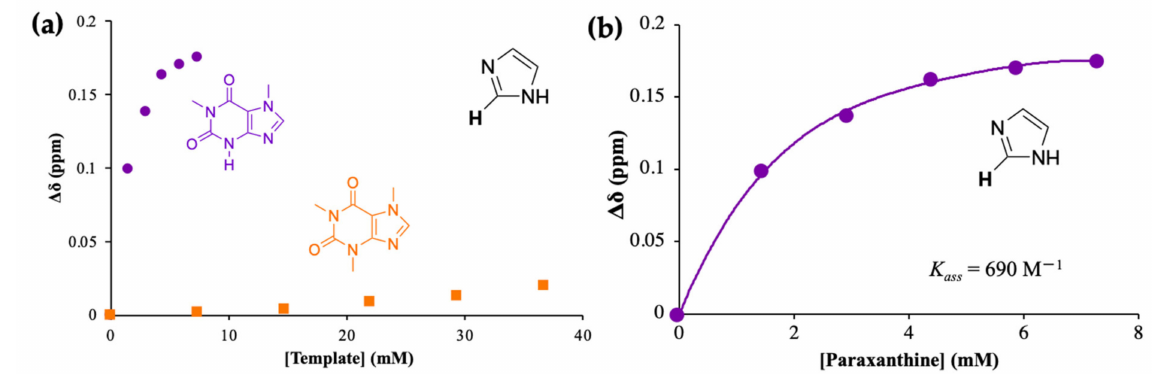
Figure 3. ( a ) 1 H NMR titrations of imidazole (IM) with paraxanthine (PX, purple) and caffeine (CAF, orange) in D 2 O, at 25 ◦ C: variation of the chemical shift of the indicated proton of IM upon stepwise increase of either PX (0–5 equivalents) or CAF concentration (0–5 equivalents) and ( b ) Variation of the chemical shift of the indicated proton of IM upon subsequent addition of PX (0–5 equivalents) in D 2 O, at 25 ◦ C. The one site-specific binding model was employed to fit the hyperbola and obtain the app K ass .